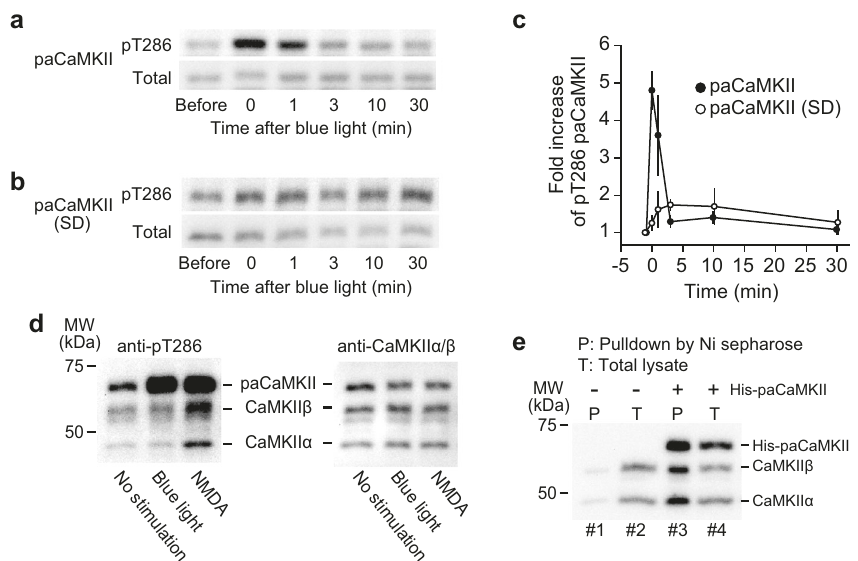
Fig. 2 Light-dependent paCaMKII autophosphorylation. The time courses of paCaMKII ( a ) and light-insensitive super-dark paCaMKII (SD) mutant ( b ) dephosphorylation at T286 after light illumination. Dissociated hippocampal neurons were infected with AAV-DJ encoding Flag-His×6-paCaMKII or mutant under CaMKII promotor were illuminated with blue light for 3 min. Right after illumination (at 0 min in the fi gure), samples were incubated in the dark for the indicated time. c Quanti fi cation of a and b . The number of samples ( n , biologically independent) at each point is as the following. For paCaMKII, before, n = 8; 0 min, n = 8; 1 min n = 4; 3 min, n = 4; 10 min, n = 4; 30 min, n = 8. For paCaMKII(SD), before, n = 6; 0 min, n = 6; 1 min n = 4; 3 min, n = 3; 10 min, n = 4; 30 min, n = 6. The band intensity of before light was used for normalization. The band intensities of pT286 were divided by those of total. The data are presented as mean ± SEM. d Selectivity of paCaMKII. Dissociated hippocampal neurons were infected with AAV-DJ encoding Flag-His×6- paCaMKII under CaMKII promotor were stimulated with no light (lane 1), blue light for 5 min (lane 2), or 20 µ M NMDA for 2 min (lane 3). The left panel shows the autophosphorylation of paCaMKII and CaMKII α / β , and the right panel shows the expression of the respective proteins. Light illumination selectively activates paCaMKII, but not CaMKII α / β (lane 2 in the left panel), whereas NMDA stimulation activates paCaMKII and CaMKII α / β (lane 3 in the left panel). e Incorporation of paCaMKII into CaMKII α / β oligomer. Dissociated cortical neurons with no transfection (lanes 1 and 2) and AAV-DJ encoding Flag-His×6-paCaMKII transfection (lanes 3 and 4) were lysed and pulled down with Ni sepharose followed by immunoblotting with CaMKII α / β antibody. In lane 3, Flag-His×6-paCaMKII was pulled down, and subsequent western blotting identi fi ed that CaMKII α / β are incorporated, suggesting that paCaMKII, CaMKII α , and CaMKII β form oligomer. Source data are provided as a Source Data fi